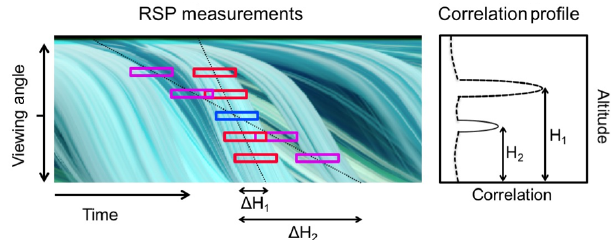
Figure 1. Illustration of the CTH retrieval approach with (a) RSP intensity measurements shown with reference nadir reflectances (blue box) along with two sets of reflectances assuming two dif- ferent cloud top heights (red and purple boxes) and (b) the corre- sponding correlation profile.